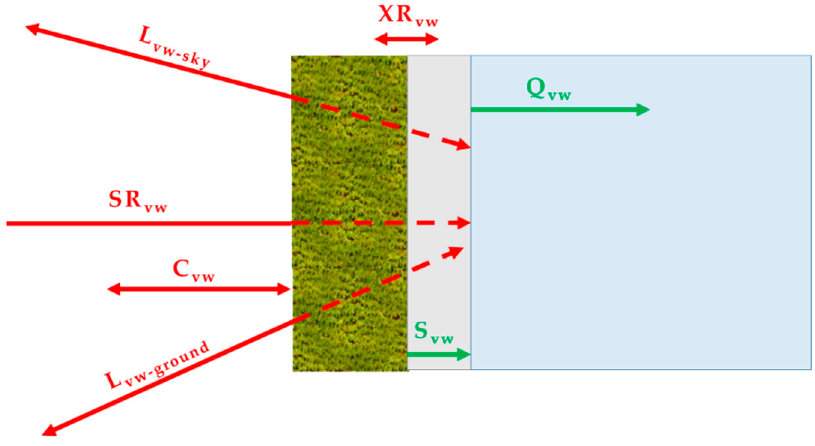
Figure 5. Vertical cross-section of the green façade model (after [22]).